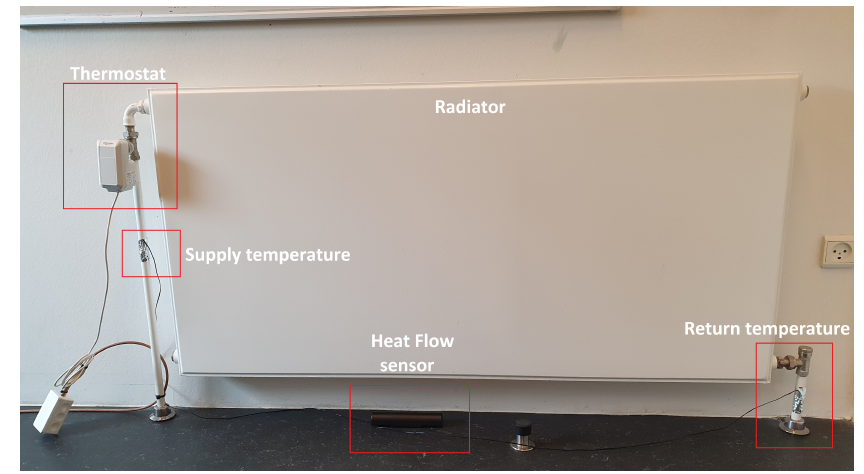
Figure 7. Heating testbed with its components.